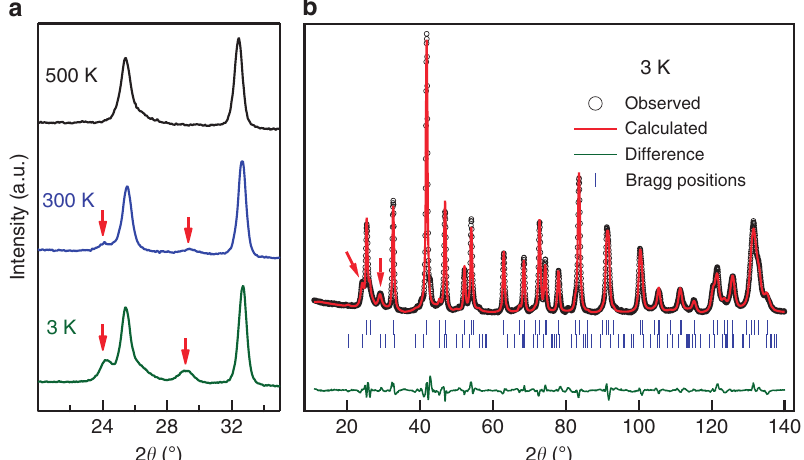
Figure 3 | Powder neutron diffraction of Pt 2 MnGa. ( a ) Detailed comparison of neutron diffraction patterns at 500, 300, and 3K. Last two cases exhibit magnetic peaks, which are indicated by red arrows. ( b ) The observed (empty circles), calculated (red line) and difference (green line) neutron diffraction patterns at 3K within the whole angular range. Upper vertical ticks mark the nuclear peak positions and lower vertical ticks mark the magnetic ones. Red arrows indicate the same magnetic peaks as considered in ( a